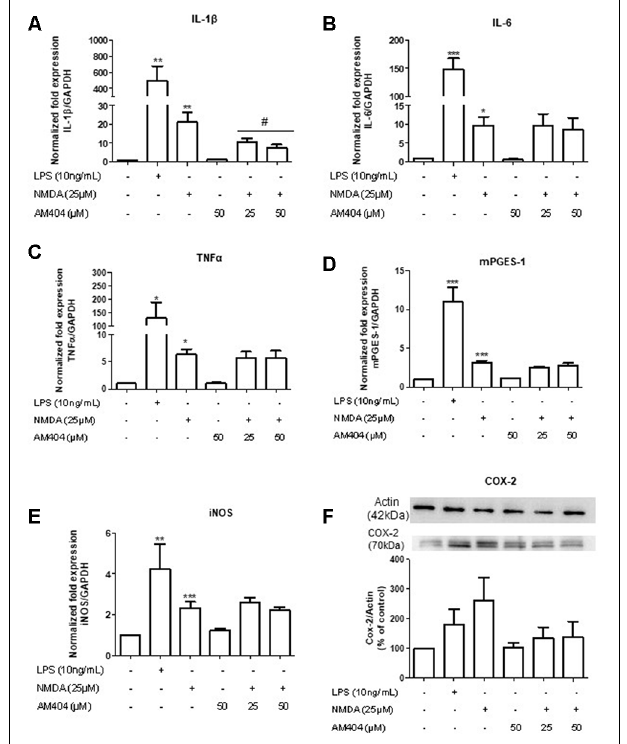
FIGURE 3 | Effects of AM404 on NMDA-induced inflammatory mediators in organotypic hippocampal slices cultures (OHSC). OHSCs were pre-treated with two concentrations of AM404 (25 or 50 µ M) for 30 min before stimulating with 10 ng/ml LPS or 25 µ M NMDA. After 4 h, interleukin (IL)-1 β (A) , IL-6 (B) , TNF α (C) , mPGES-1 (D) , and iNOS (E) were measured by PCR. After 24 h, COX-2 (F) was evaluated by western blot (WB). Data are expressed as mean ± SEM of at least three OHSCs/group. ∗ p < 0.05, ∗∗ p < 0.01 and ∗∗∗ p < 0.001 with respect to negative control and # p < 0.05 in comparison to 25 µ M NMDA (one-way ANOVA followed by the Newman–Keuls